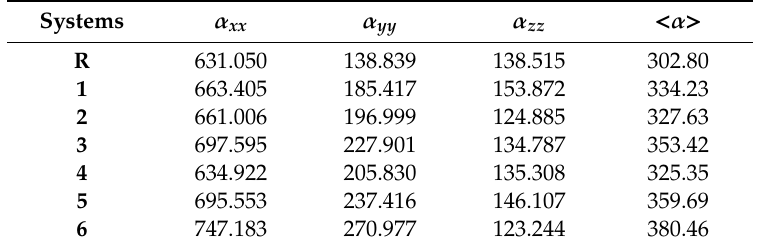
Table 4. Polarizabilities and major contributing tensors (a.u.) of R and 1 – 6 in solvent (DMSO) at the CAM-B3LYP / 6-31G(d,p) level of theory.